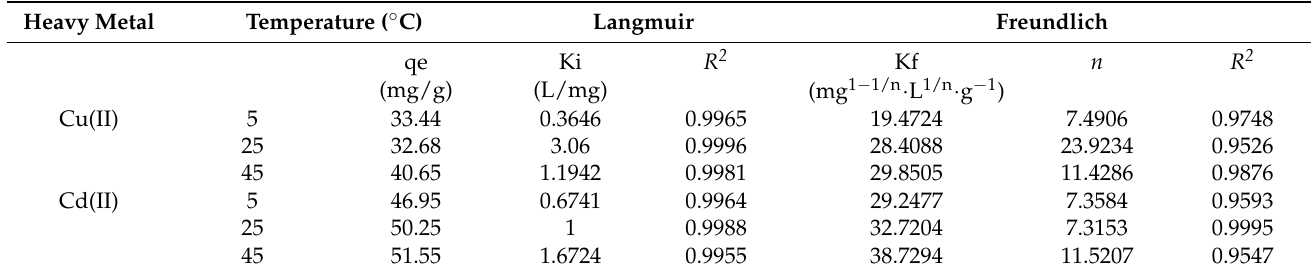
Table 7. Fitted data from the KAM500-400-3 isotherm model adsorbing Cu(II) and Cd(II). Heavy Metal Temperature ( ◦